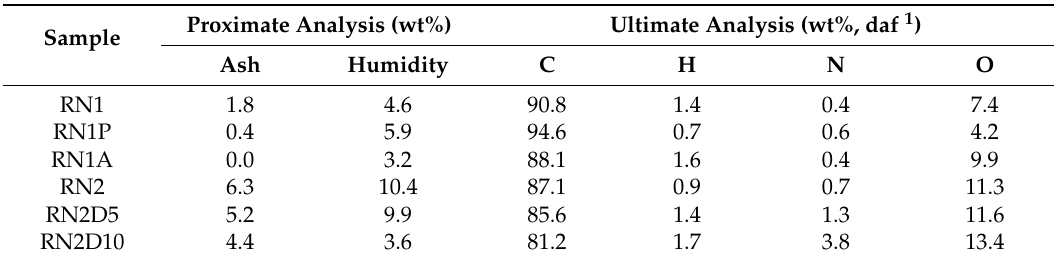
Table 1. Chemical analysis of the